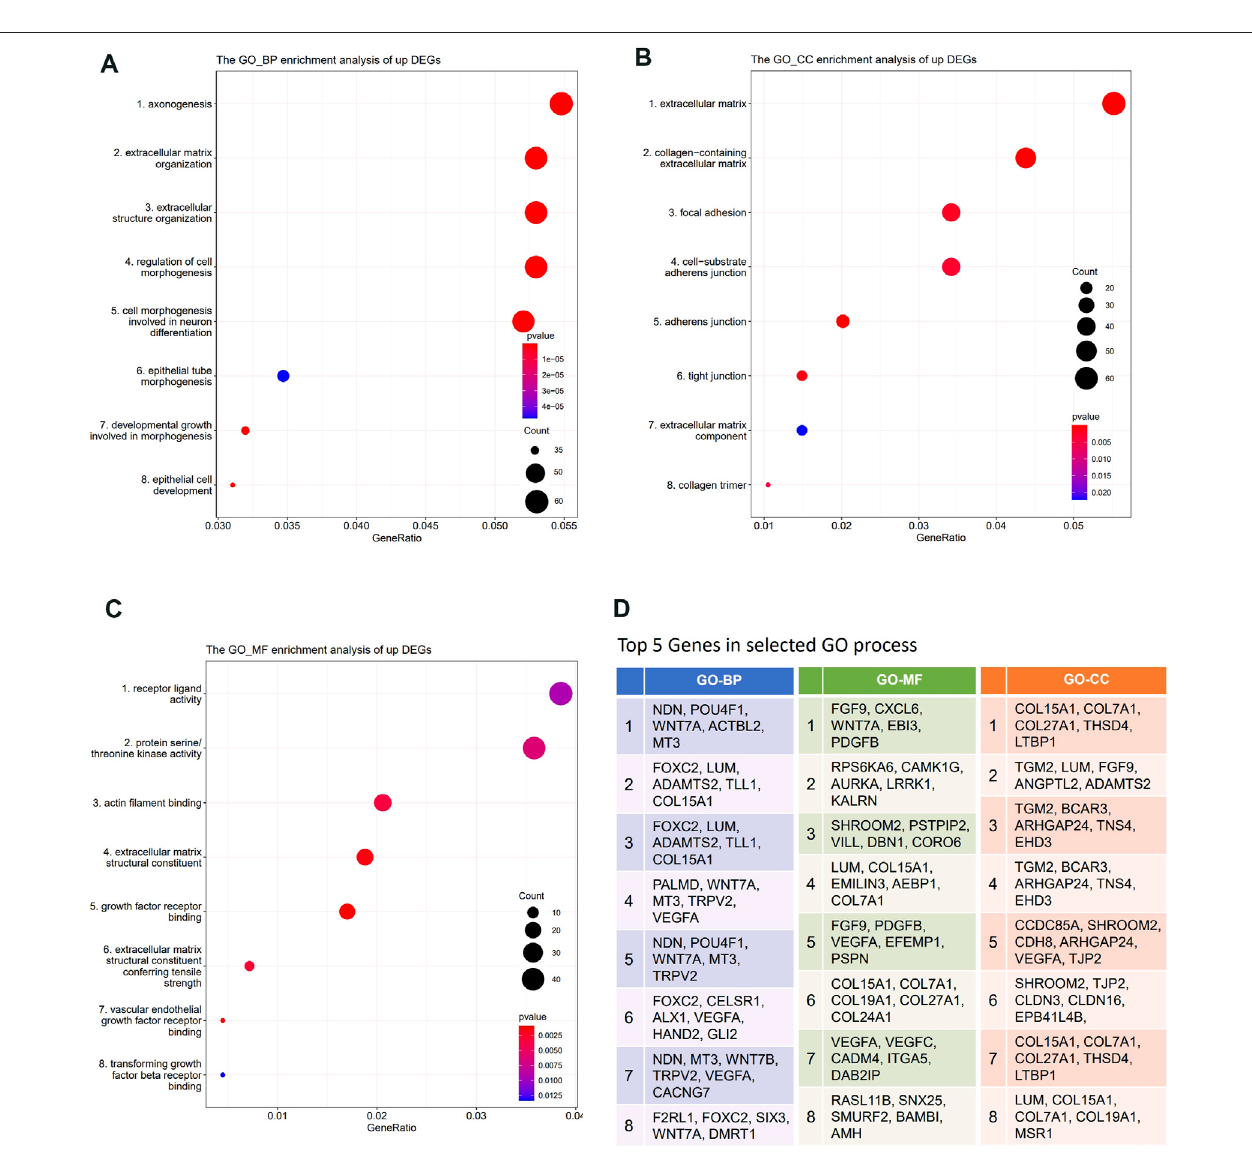
FIGURE 5 | Transcriptome analysis of DEGs between DBTRG and U251. (A) GO_BP enrichment analysis of the upregulated genes in DBTRG. (B) GO_CC enrichment analysis of the upregulated genes in DBTRG. (C) GO_MF enrichment analysis of the upregulated genes in DBTRG. (D) Top fi ve genes in the selected GO